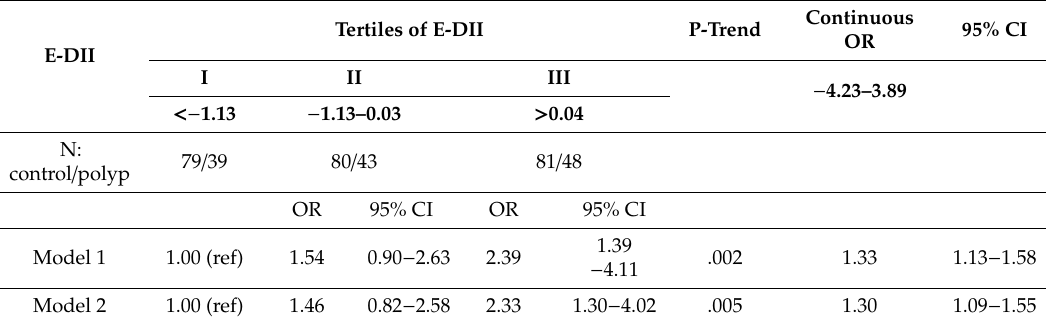
Continuous 95% CI OR